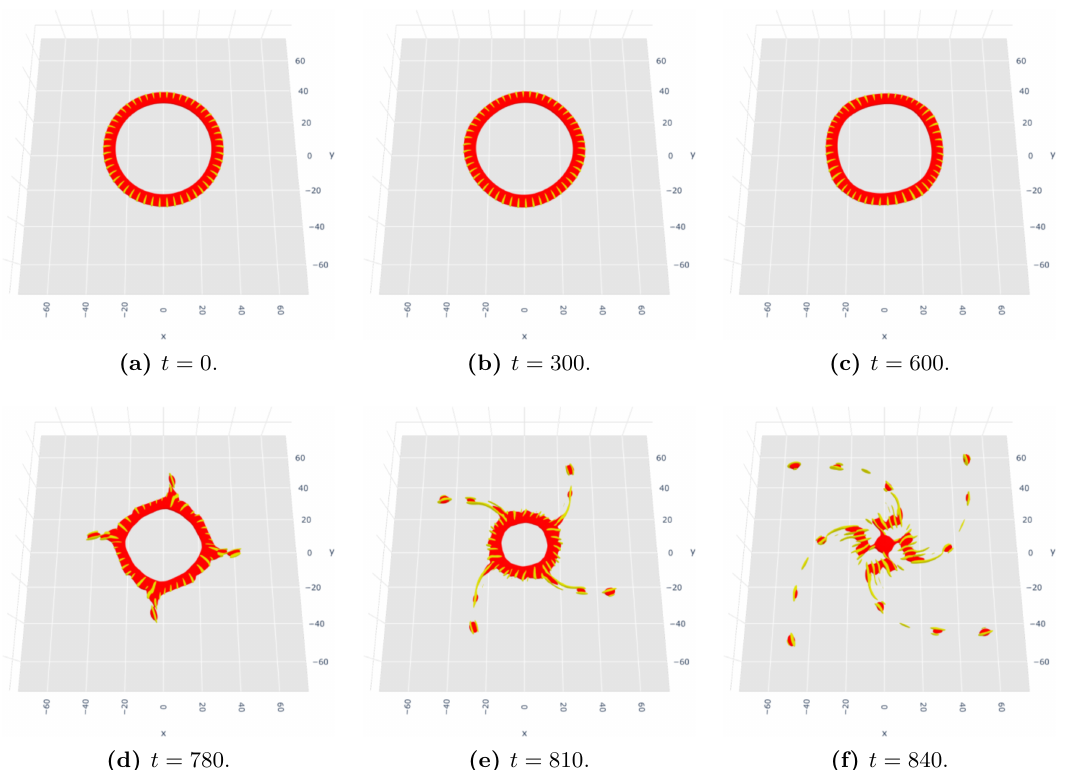
Figure 24 . Isosurfaces of a vorton with Q = 749 and N = 50 in the paramater set η σ = 0 . 35 , λ σ = 36 , β = 6 . 6 and G = 0 . 2 (parameter set A). | φ | = 3 η φ is shown in red and Re ( σ ) = 1 η σ is shown in 5 5 yellow. By the end of the simulation, it is clear that the vorton is unstable to square perturbations, probably sourced by the discretized grid, and that this instability eventually destroys the vorton. The development of an unstable square mode is similar to what is seen in parameter set D in